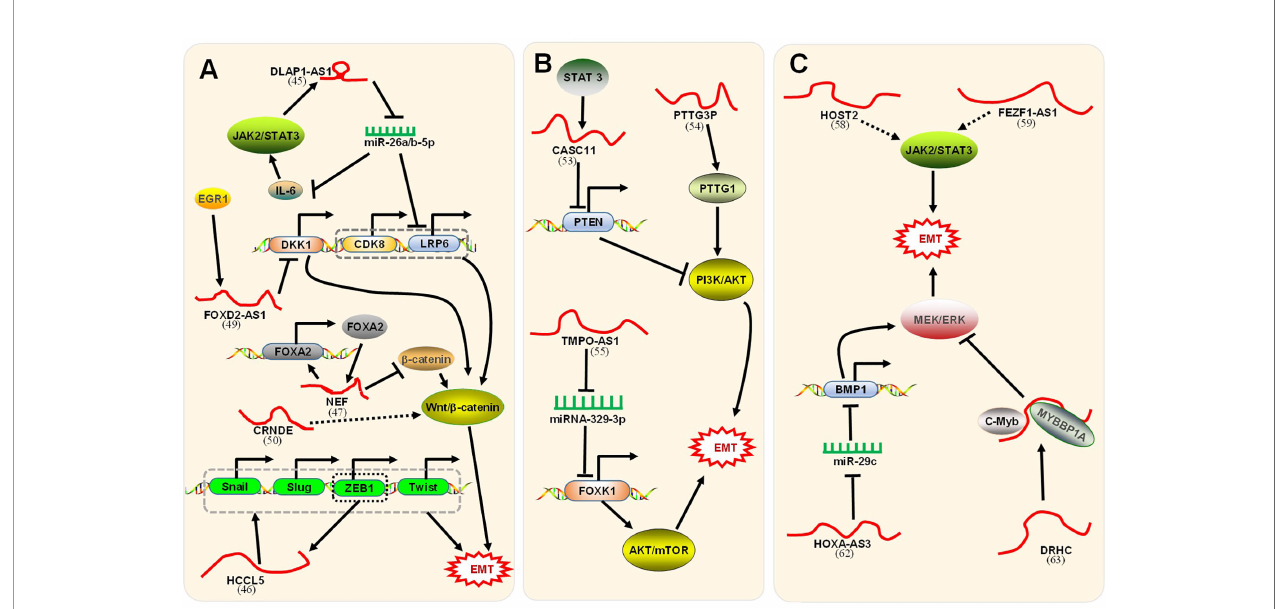
FIGURE 3 | Signaling pathways associated with lncRNAs regulation of EMT. (A) The positive feedback loop and Wnt/ b -catenin signaling pathway. First, DLGAP1- AS1 (47) promoted EMT through a positive feedback loop. Mechanistically, 1) DLGAP1-AS1 sponged and sequestered miR-26a-5p and miR-26b-5p to upregulate IL-6. IL-6 stimulated the JAK2/STAT3 signaling pathway, which conversely promoted DLGAP1-AS1. 2) DLGAP1-AS1 activated the Wnt/ b -catenin pathway by upregulating the downstream CDK8 and LRP6 of miR-26a/b-5p. Second, HCCL5 (60) accelerated EMT by upregulating the expression of Snail, Slug, ZEB1, and Twist1. In turn, HCCL5 was transcriptionally driven by ZEB1. Third, lncRNA-NEF (61) was transcriptionally activated by FOXA2 and, in turn, activated its neighboring gene FOXA2. LncRNA-NEF interacted with b -catenin to increase the binding of GSK3 b with b -catenin, leading to the suppression of Wnt/ b -catenin signaling. Fourth, lncRNA FOXD2-AS1 (62) induced by EGR1 promoted the EMT process by binding with EZH2 to epigenetically silence the DKK1 gene and activating the Wnt/ b - catenin axis. Fifth, CRNDE-promoted Wnt/ b -catenin signaling pathway activity was inhibited by CRNDE (63) knockdown. Unfortunately, the paper did not clarify how CRNDE reduces the level of signaling pathway-related proteins. (B) The PI3K/AKT/mTOR signaling pathway. First, STAT3-induced lncRNA CASC11 (64) promotes EMT by binding with the enhancer of EZH2 to epigenetically silence PTEN and activate the PI3K/AKT axis. Second, lncRNA PTTG3P (65) promotes EMT by upregulating PTTG1 and activating the PI3K/AKT axis. Third, TMPO-AS1 (42) upregulated the oncogene FOXK1 by sponging miR-329-3p to activate the AKT/mTOR signaling pathway. (C) The JAK2/STAT3 signaling pathway and MEK/ERK signaling pathway. First, HOST2 (66) enhanced EMT by upregulating the JAK2-STAT3 signaling pathway. Second, FEZF1-AS1 (67) increased EMT via the JAK2/STAT3 signaling pathway. Third, HOXA-AS3 (68) upregulated BMP1 by sponging miR-29c, thus activating the MEK/ERK signaling pathway to enhance EMT. Fourth, the DRHC/MYBBP1A/C-Myb (69) complex with C-Myb inhibited the MEK/ERK signaling pathway and fi nally inhibited EMT. The corresponding references were also indicated under the lncRNA names on the fi